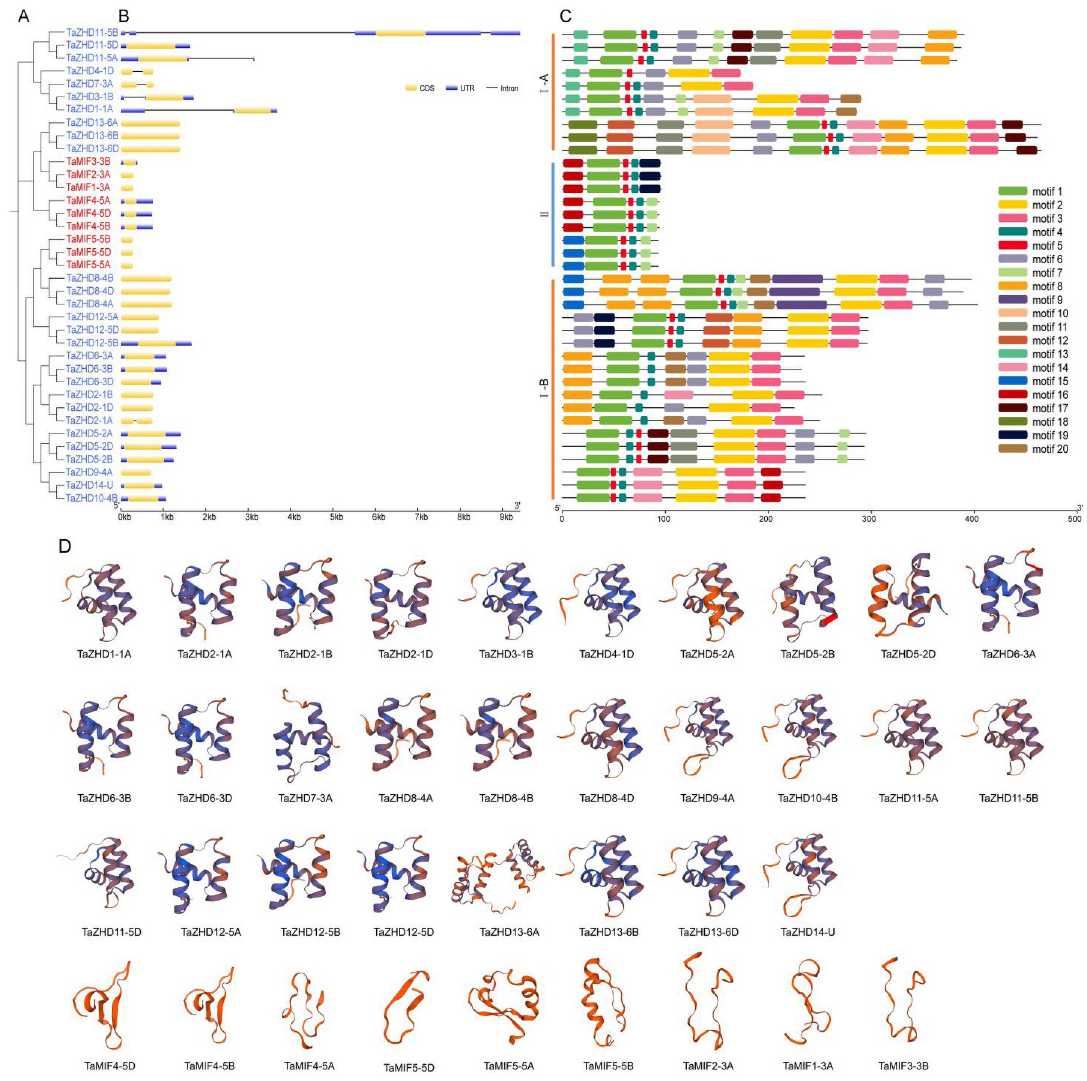
Fig 2. Phylogenetic tree, gene structure and motif analysis of wheat ZF-HD family. ( A ) The phylogenetic tree of TaZF-HDs. The tree was created using the Neighbor-joining (NJ) method. ( B ) The exon-intron structure of the TaZF-HDs . Exon-intron structure analyses were conducted using the GSDS server. The untranslated regions (UTRs) are indicated by blue boxes, the exons are indicated by yellow boxes and the introns are indicated by black lines. ( C ) The motifs of TaZF-HDs were identified by MEME tool. Each motif is indicated with a specific color. ( D ) Tertiary structure prediction of TaZF-HD